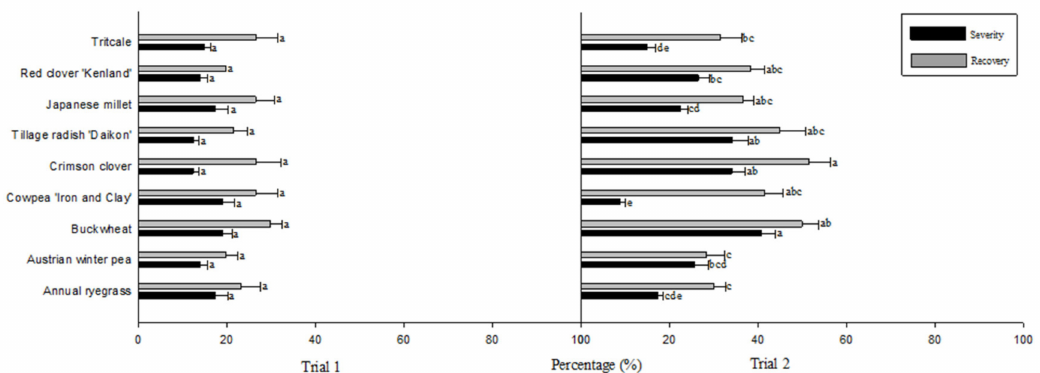
Figure 2. Disease severity and recovery (mean ± SE) of cover crops when Phytopythium vexans was inoculated in the soil. Phytopythium root rot disease severity was evaluated using a scale of 0–100% of roots affected. For each replication, ten randomly selected cover crop root samples were plated V8-PARPH oomycete-selective medium to determine the percent recovery of P. vexans from root samples. Different letters on the bars indicate significant differences in Phytopythium root rot disease severity and pathogen recovery among cover crops (Trial 1: Severity: F = 1.75, p = 0.1129; Recovery: F = 0.8, p = 0.0603; Trial 2: Severity: F = 16.13, p < 0.0001; Recovery: F = 4.53, p = 0.0004; df MST,MSE = 8, 45; α = 0.05, least square